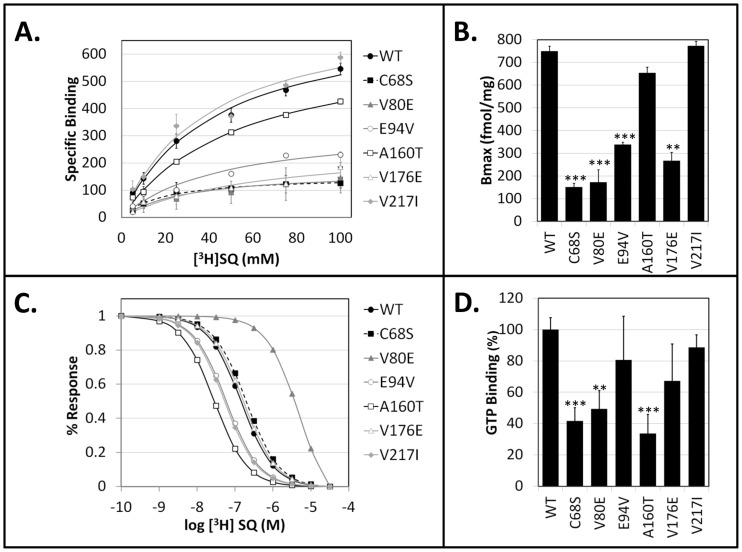
Competition and Saturation Binding Analysis.
A. Saturation binding curves of hTP variants demonstrates a spectrum of binding deficits ranging from completely wild type (V217I) to severely dysfunctional (C68S). B. Histogram of the cell surface expression (Bmax) for each of the genetic variants analyzed. Significant differences from WT are highlighted (*p<0.05, **p<0.01, ***p<0.001). C. Competition binding of hTP variants demonstrates the relative affinity of antagonist for binding-competent receptors remains mostly normal. Statistically significant differences was observed only for A160T (increased affinity) and V80E (decreased affinity). D. GTPγS activation by hTP Variants upon treatment with TP agonist U-46619. Non-synonymous variants of hTP demonstrate different capacity to maximally stimulate effector signaling through GTPγs. The V217I, V176E, and E94V were indistinguishable from wild-type hTP receptor. Each of the other hTP genetic variants, C68S, V80E, and A160T, each demonstrate deficient effector activation with 80 nM U-46619 agonist stimulation. (*p<0.05, **p<0.01, ***p<0.001) Further details are provided in Table 3.